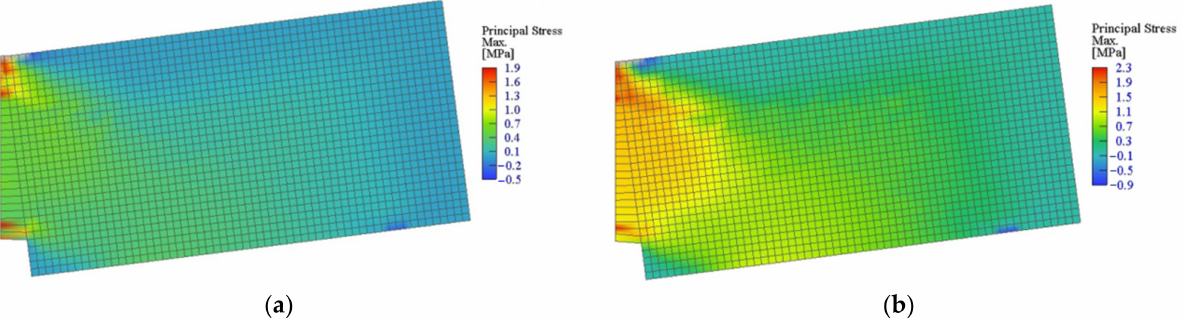
Figure 18. Maximum principal stress in all models for CMOD = 2.5 mm: ( a ) 0.5% and ( b )